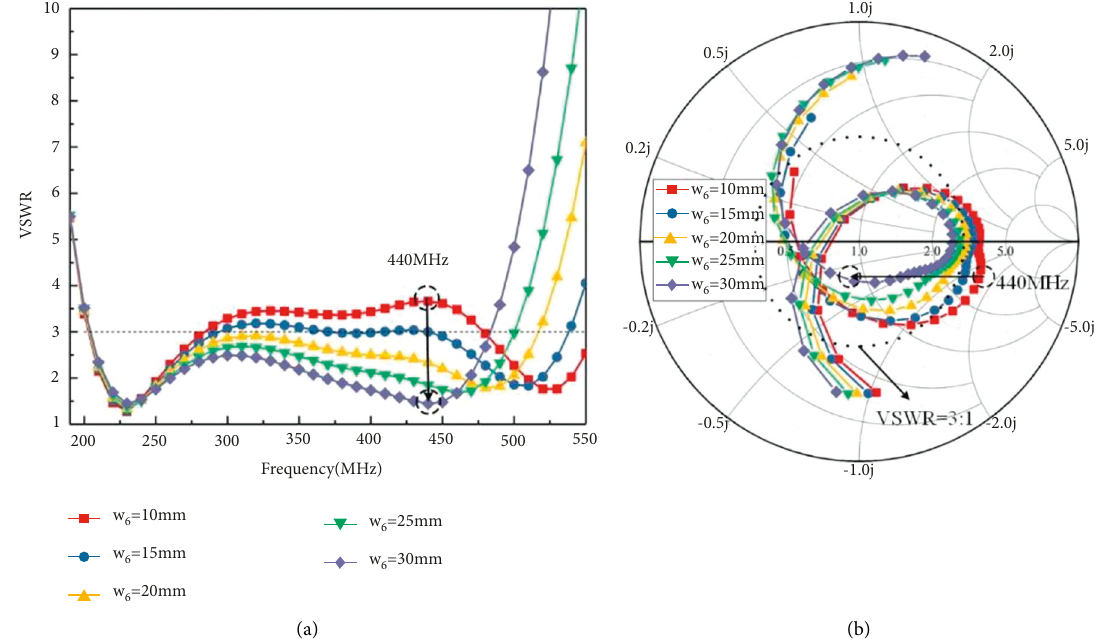
Figure 12: (a) VSWR curves and (b) Smith charts with different values of w